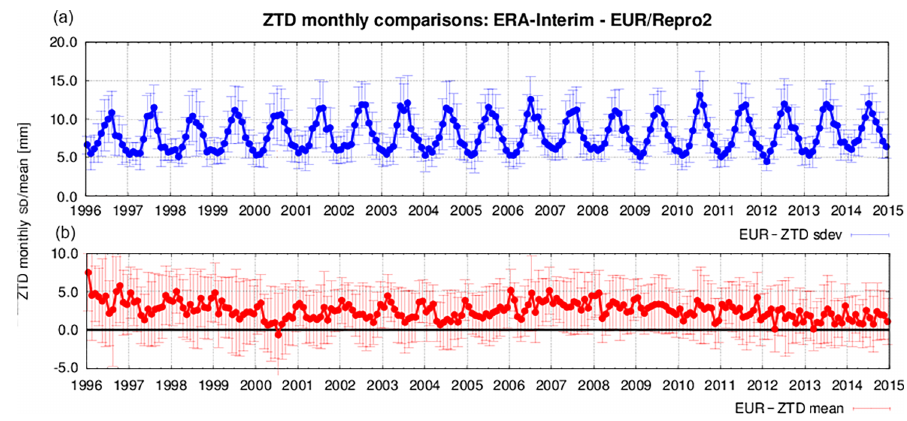
Figure 13. Time series of monthly mean biases (b) and standard deviations (a) for ZTD differences between EPN-Repro2 and ERA-Interim reanalysis (ERA-Interim minus GNSS). Uncertainties are calculated over all stations.